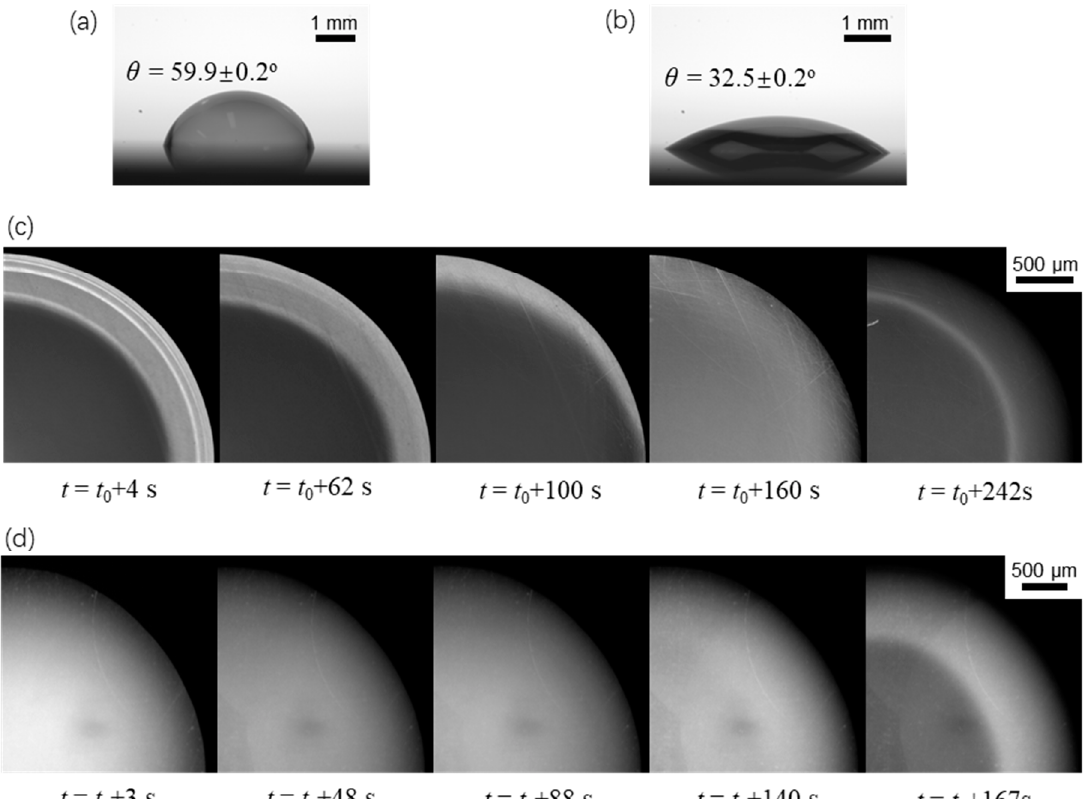
Figure 7. Evaporation dynamics of an evaporating sessile water drop on surfaces with two different initial contact angles. ( a ) θ = 59.9 ± 0.2° and ( b ) θ = 32.5 ± 0.1° show the contact angles of two drops right after loading onto the substrate. ( c , d ) are top-view images on the corresponding surfaces showing variation of the fluorescence intensity.